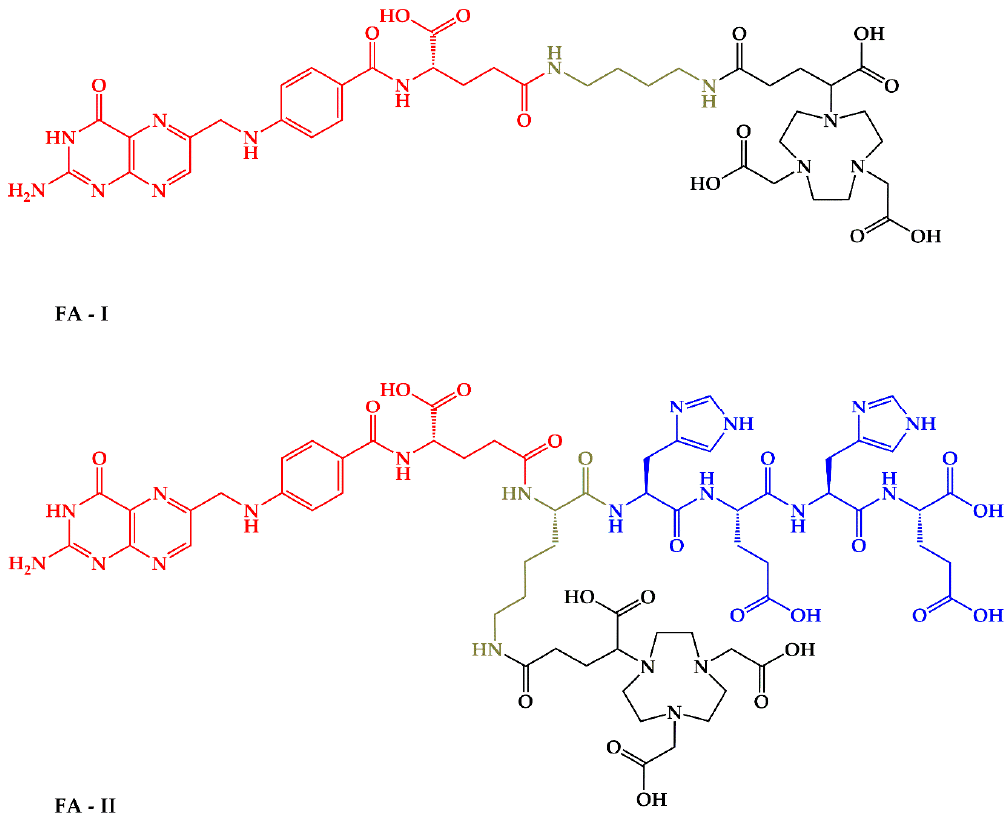
Figure 1. Chemical structure of FA-I and FA-II with marked moieties: red-folic acid vector moiety; black–NODAGA chelator for 68 Ga coordination; green–linkers; blue–(HE) 2 -tag for pharmacokinetic properties optimization.